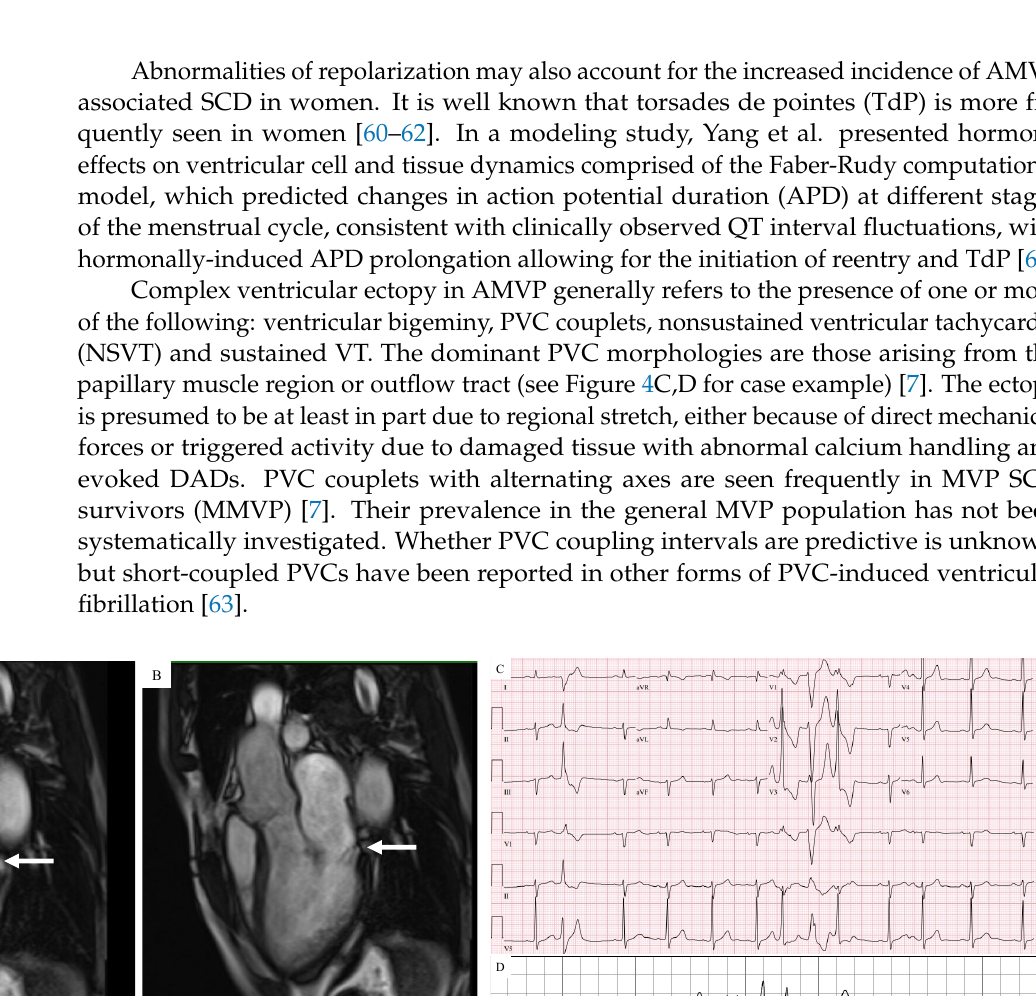
Figure 3. 12-lead ECG in a patient with bileaflet MVP. ( A ) ECG reveals TWI in multiple leads as well as bigeminal PVCs that have a posteromedial papillary muscle morphology. ( B ) Repeat ECG following PVC ablation demonstrates an improvement in TWI.